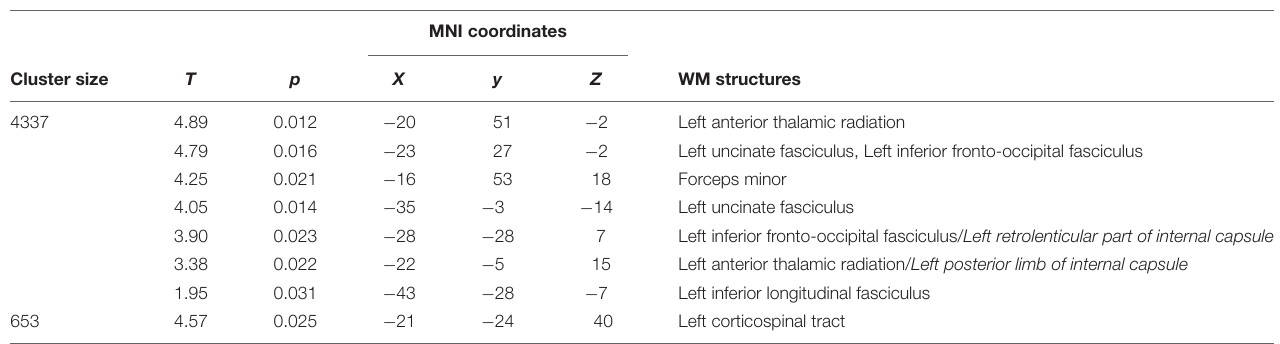
Refer to Table 2 for a detailed explanation of the table